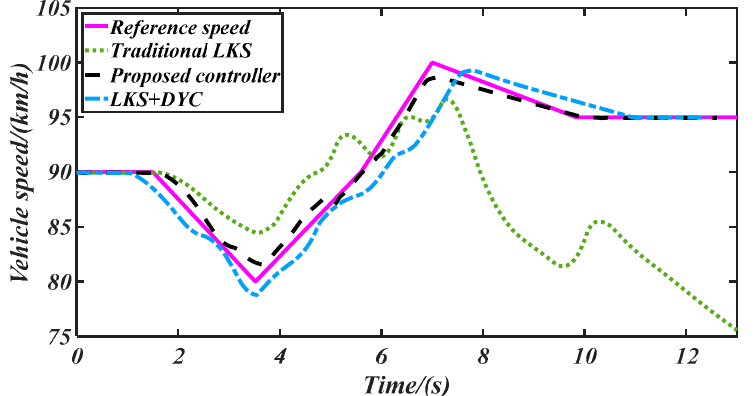
Figure 12. The nominal vehicle speed and real vehicle speed controlled by different controllers.